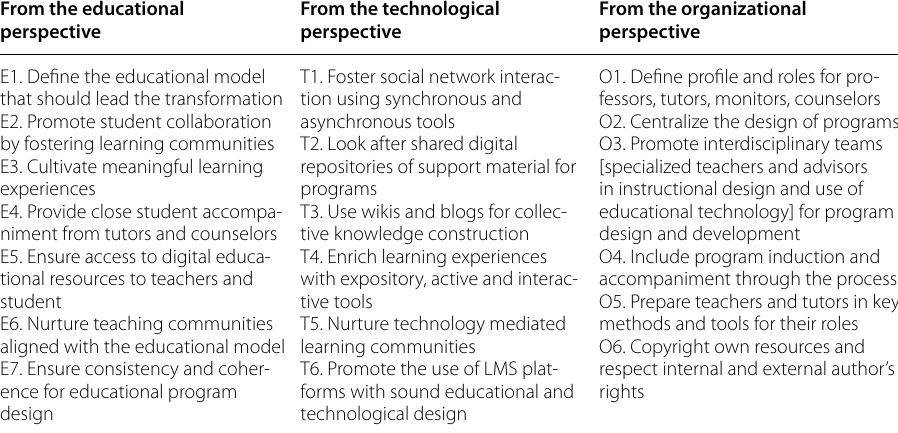
Table 1 What to do for a successful institutional transformation using bLearning and / or eLearning From the educational From the technological perspective